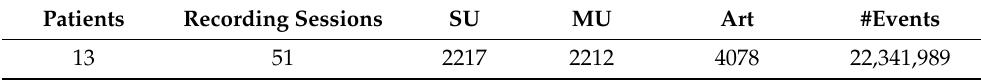
Table 1. Overview of recorded sessions used to optimize the DER algorithm.